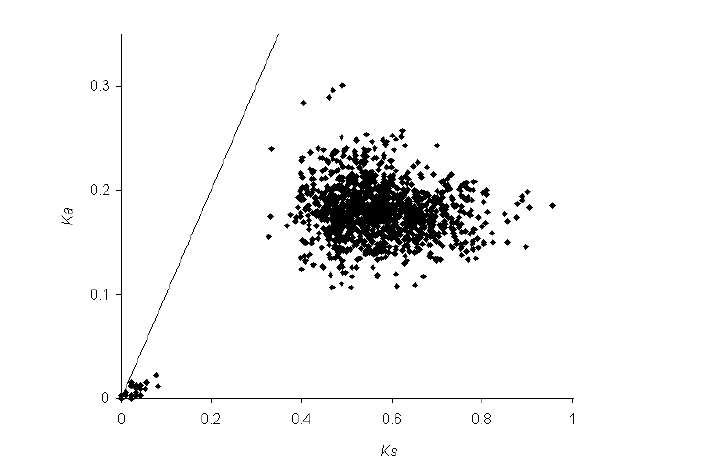
Figure 4: Positively selected sites view.